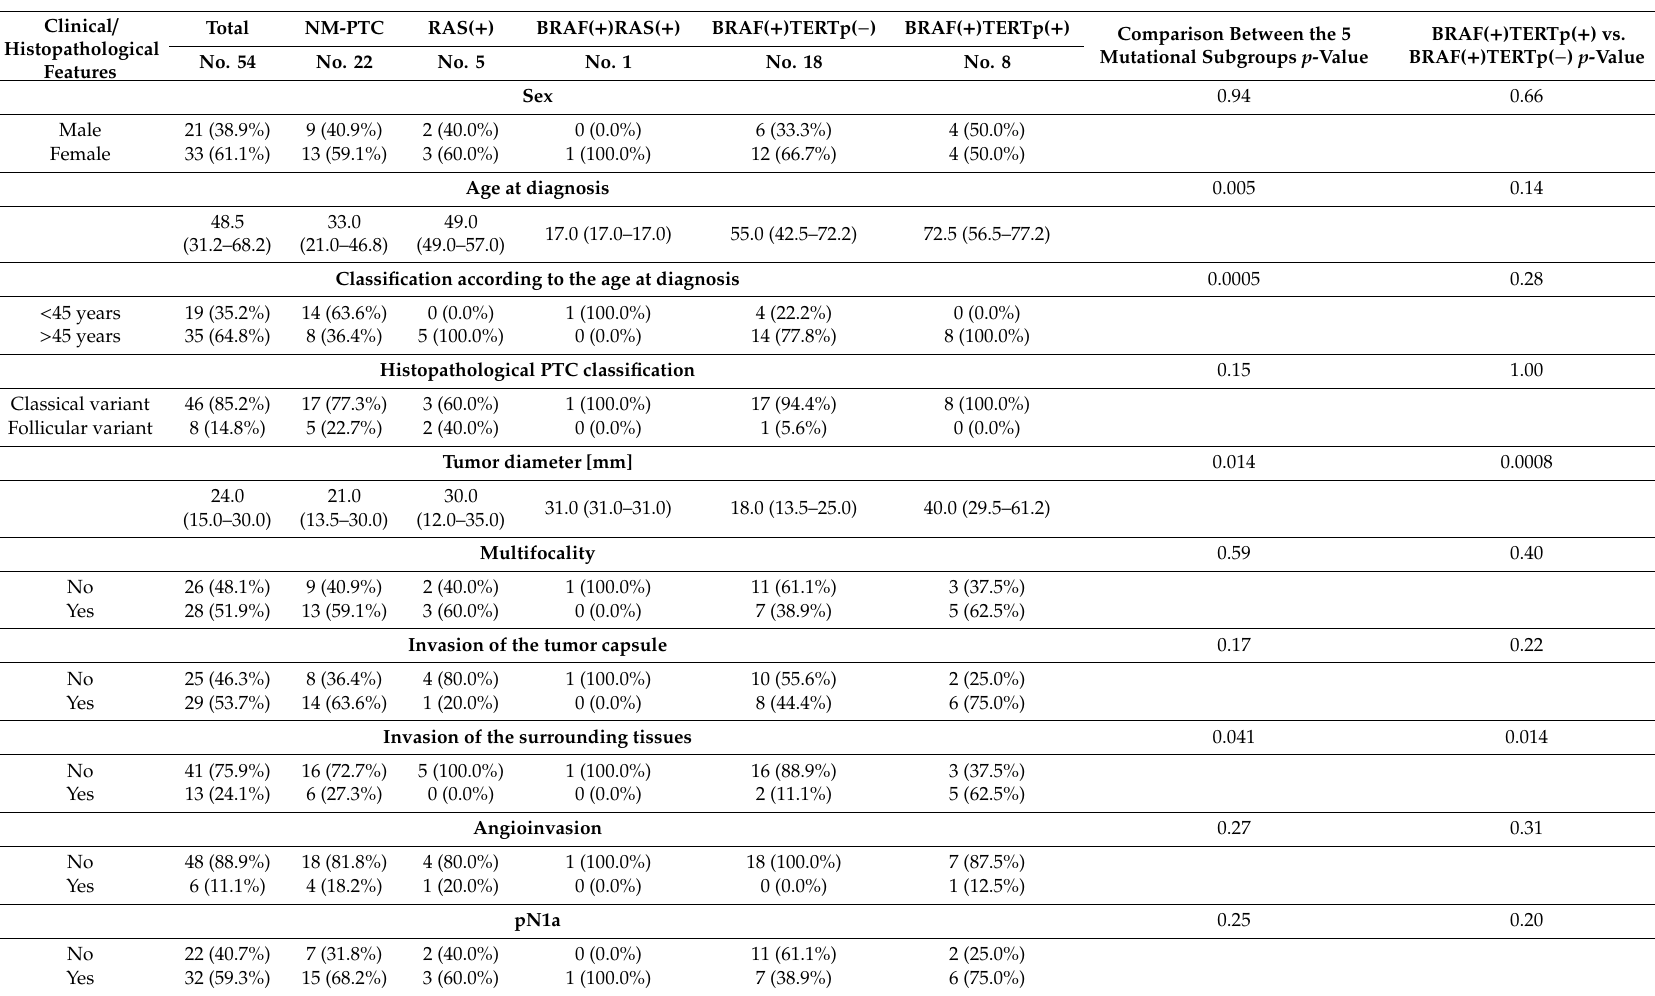
Table1. CharacteristicsofanalyzedPTCcohortwith BRAF , RAS and TERT pmutationalstatus,